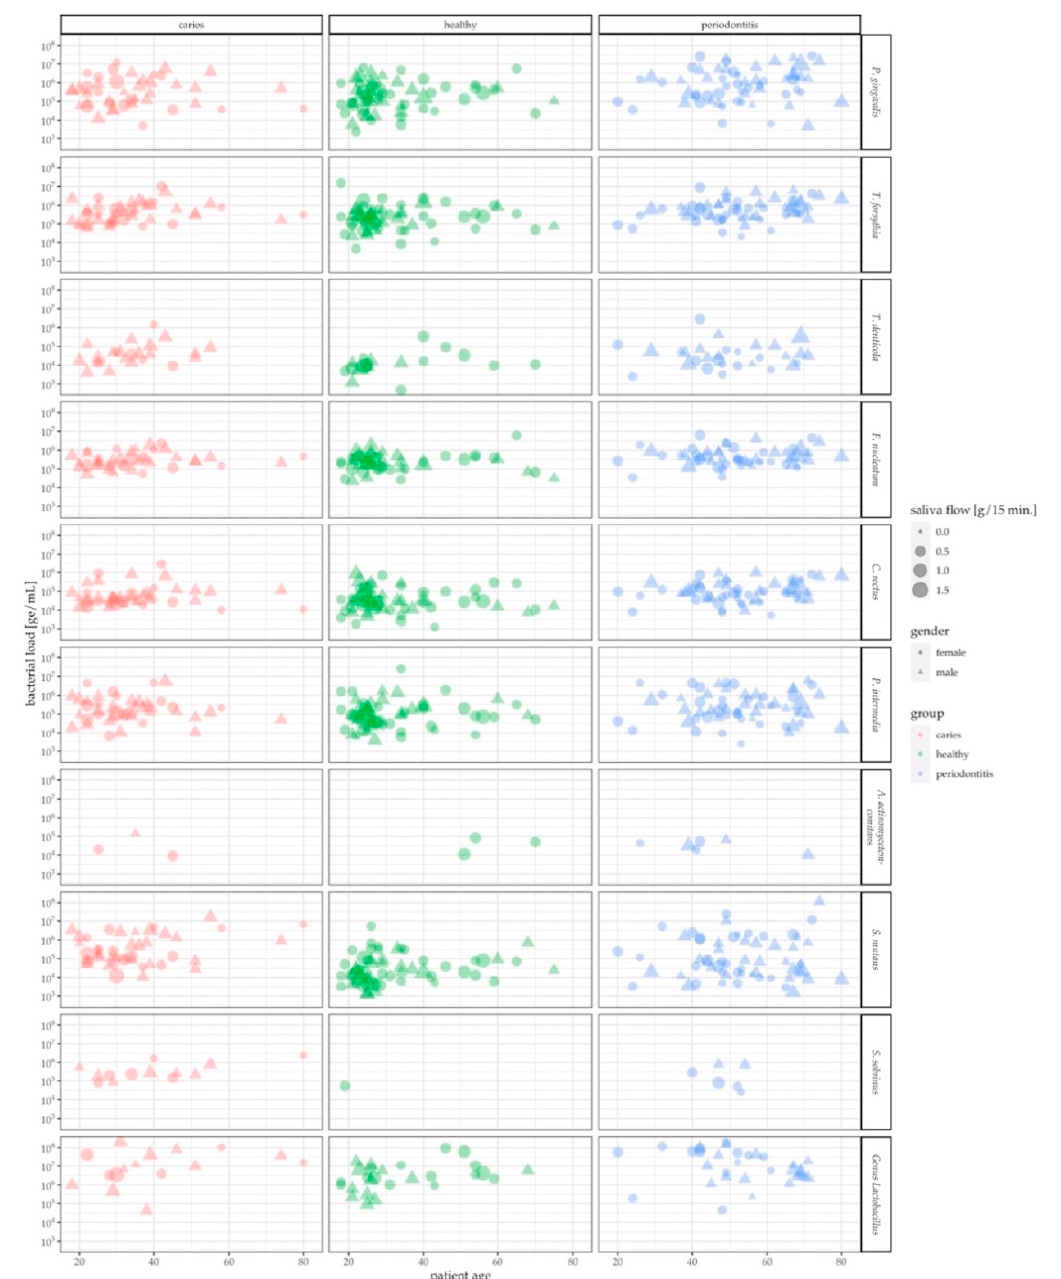
Figure 3. Overview of the age, gender and saliva flow rate distribution. Depending on their classification, data from caries patients are displayed in red (left), healthy individuals in green (middle) and periodontitis patients in blue (right). The bacterial loads in genome equivalents (ge / mL) are presented for all analyzed bacterial strains, captioned for each strain on the right.